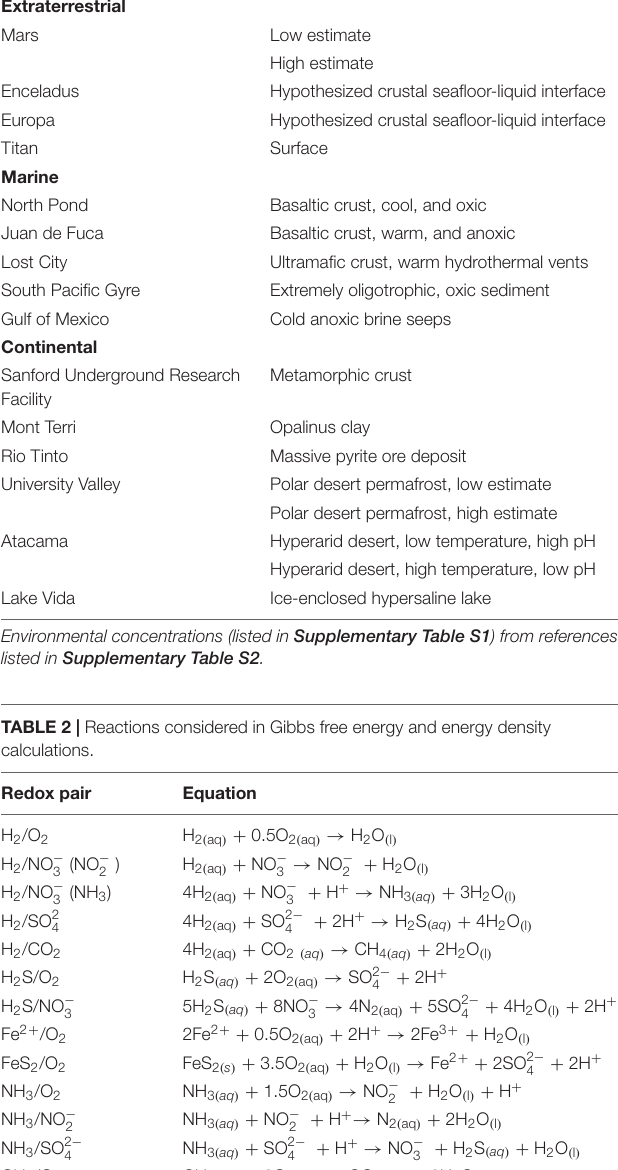
( Table 1 ), we calculated the Gibbs free energy yield of reactions under in situ conditions for a suite of reactions ( Table 2 ),